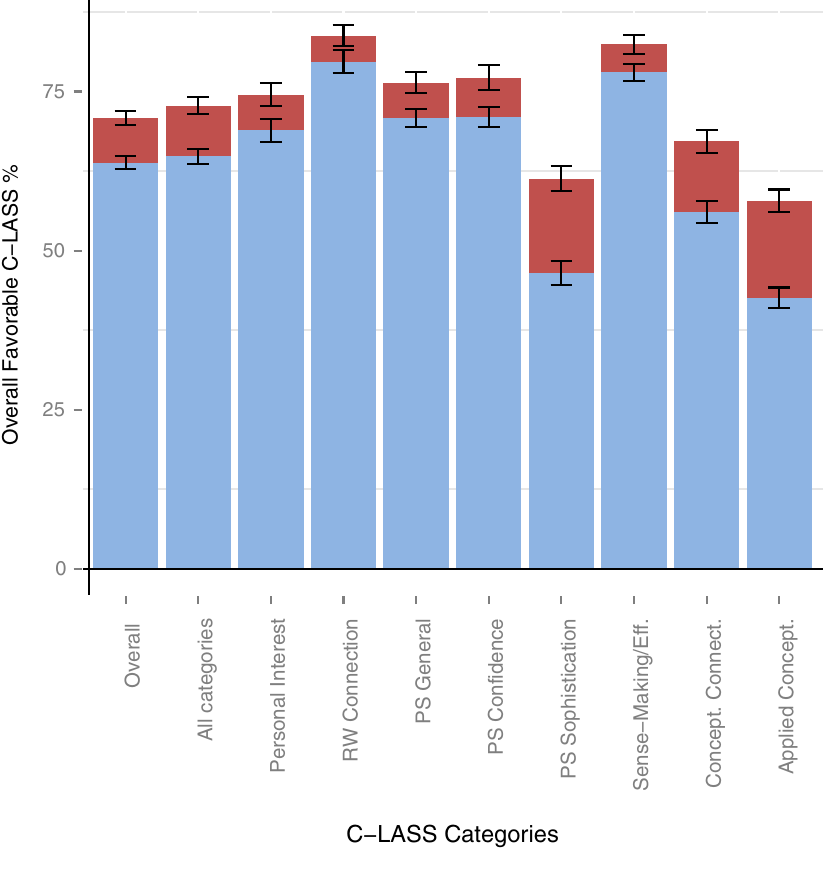
FIG. 4 (color online). MI-New CLASS data ( N ¼ 221 ) for all categories. Blue and red represent the pre- and postcourse percentages, respectively, of overall favorable responses. The error bars show standard error for pre and